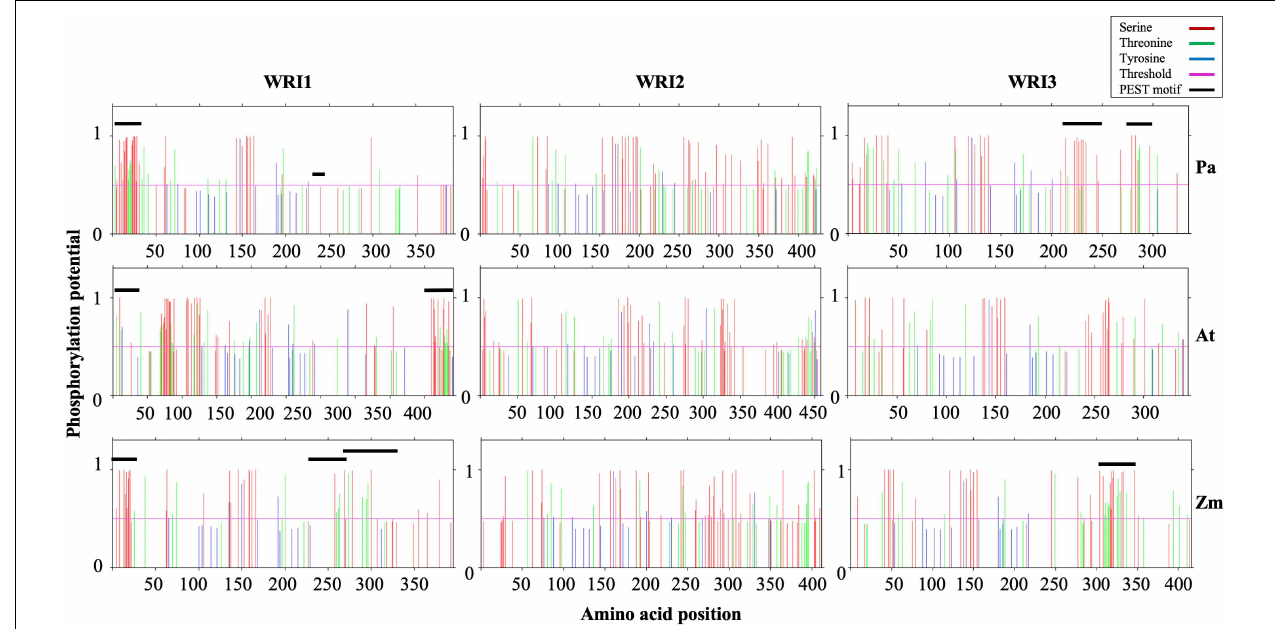
FIGURE 4 | Schematic presentation of potential phosphorylation sites in the WRI homologs. Predicted phosphorylation potential for S (Red), T (green), and Y (blue) residue and their amino acid position are shown in the plots. The residues with potential higher than threshold value of 0.5 have higher probability of being phosphorylated. Residues that correspond to PEST motifs are also indicated by a black